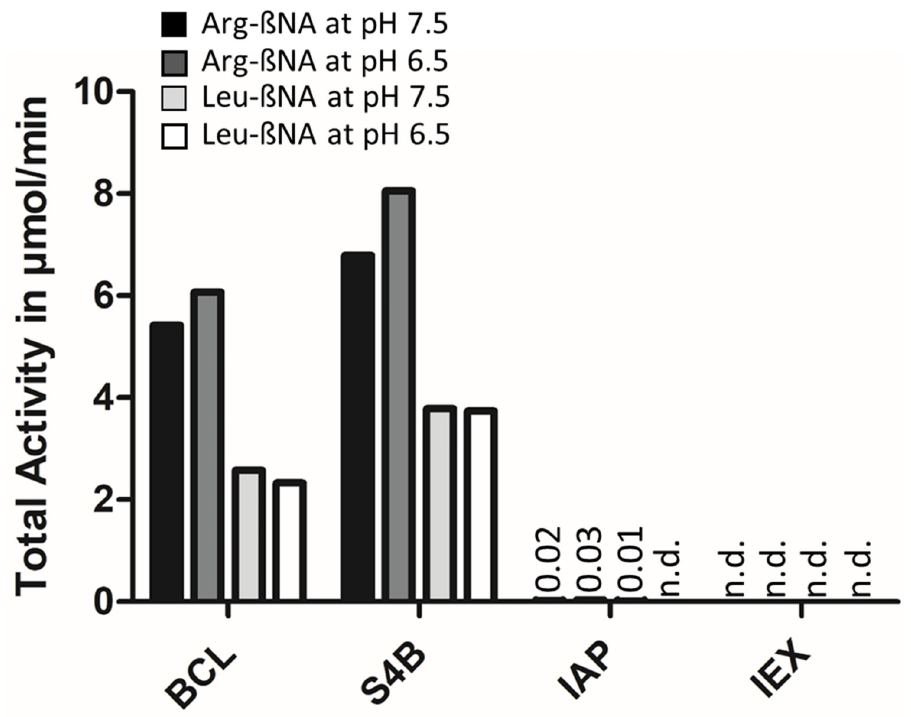
Fig 4. Arg-ßNA and Leu-ßNA hydrolyzing activities of DPP3 containing fractions during purification. DPP3 activity was assayed at pH 7.5 and pH 6.5 with Arg-ßNA or Leu-ßNA as substrates. All tested fractions were diluted to a DPP3 content of 100 μ g/mL (DPP3-LIA) and assayed as described in materials and methods. Black bar: reaction at pH 7.5 with Arg-ßNA as substrate, dark-grey bar: reaction at pH 6.5 with Arg-ßNA as substrate, light-grey bar: reaction at pH 7.5 with Leu-ßNA as substrate, white bar: reaction at pH 6.5 with Leu-ßNA as substrate. BCL: Blood cell lysate, S4B: Sepharose 4B, IAP: immuno-affinity purification, IEX: ion-exchange.